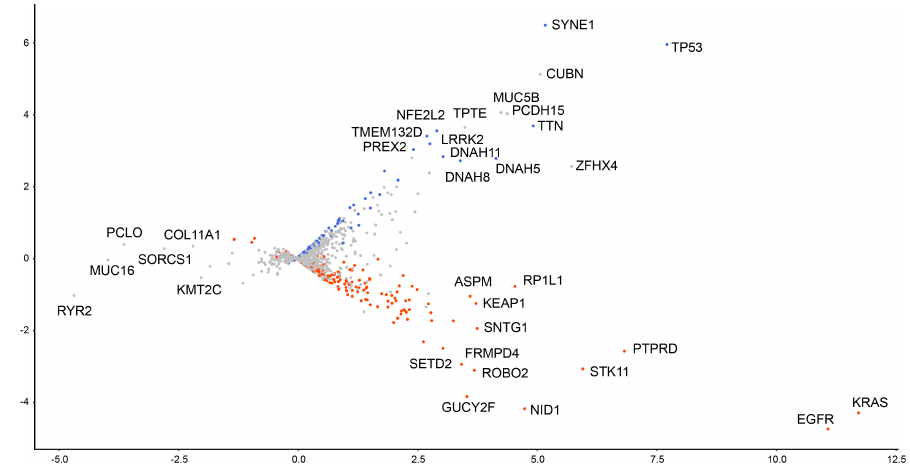
Figure 5. Principal component analysis (PCA) plots of hidden representations with names of genes for Diet Networks with element-wise input scaling (EIS) ( γ = 0.1). Horizontal axis and vertical axis indicate the first and second principal components, respectively. Lung adenocarcinoma (LUAD)-dominant genes and lung squamous cell carcinoma (LUSC)-dominant genes are colored red and blue,